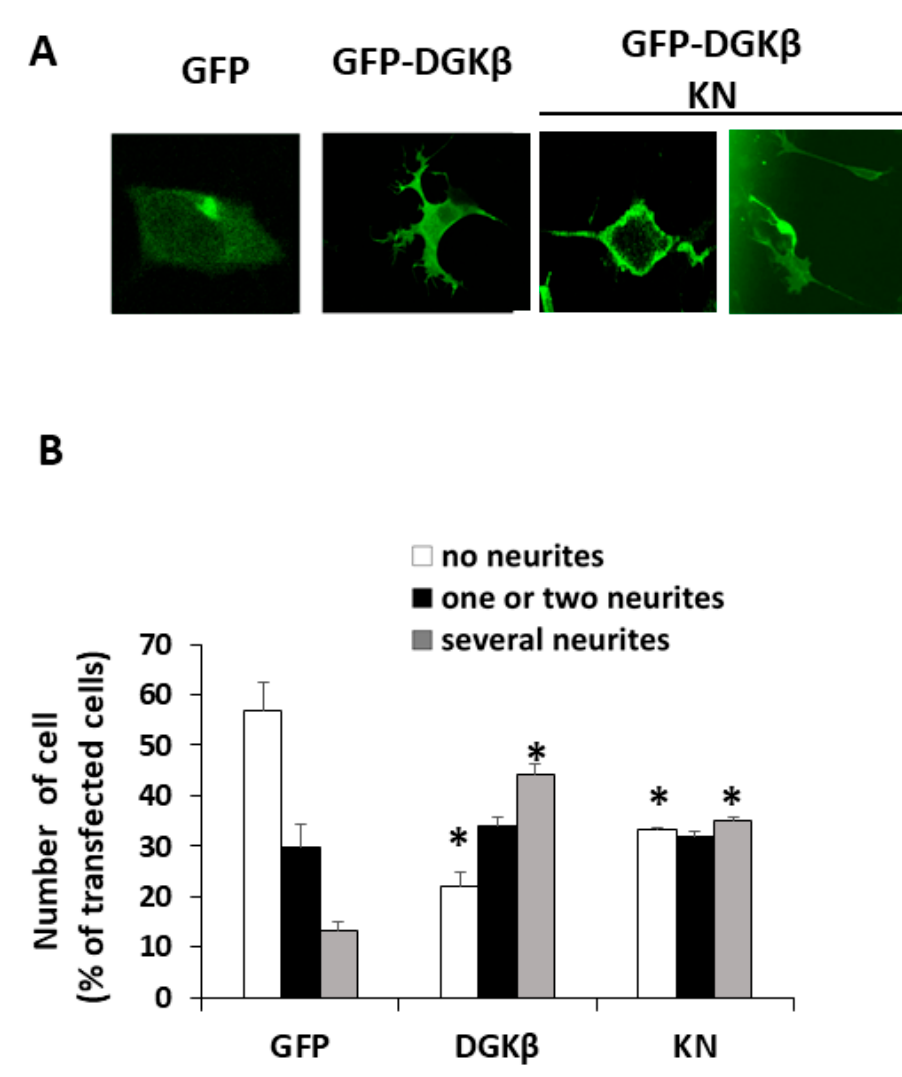
Figure 1. DGK β KN-induced neurite outgrowth in SH-SY5Y cells. ( A ) Typical images of SH-SY5Y cells overexpressing green fluorescent protein (GFP), GFP-DGK β or GFP-DGK β KN. ( B ) Comparison of the number of cells having no (white column), one or two (black column) and several neurites (gray column) by overexpressing GFP (control), GFP-DGK β (WT) or GFP-DGK β KN (KN). More than 100 cells were observed in each experiment and three independent experiments were performed. The mean and SEM of number of the cells are shown as percentage to the transfected cells. * p < 0.05 followed by Student’s t -test (vs. the respective controls expressing GFP alone).